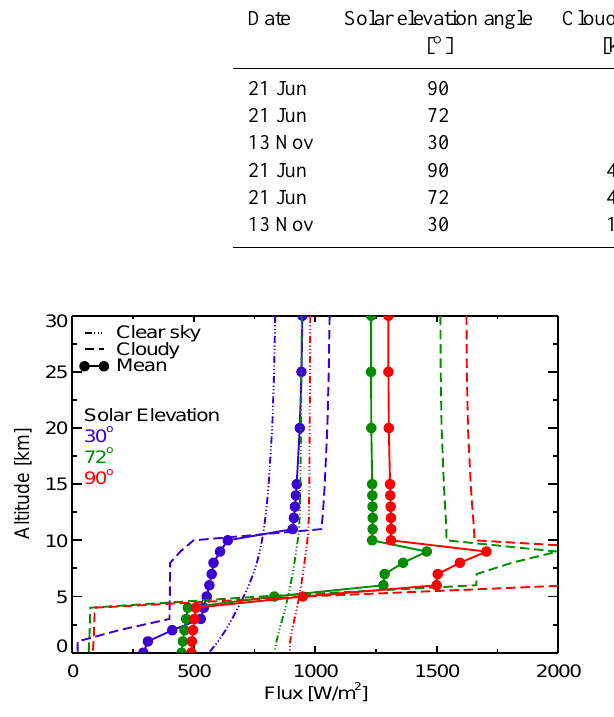
Figure 5. Vertical profiles of the total actinic flux on the sensor Fig. 5. Vertical profiles of the total actinic flux on the sensor for solar elevation angles of 30, 72 and 90 ◦ . The for solar elevation angles of 30, 72, and 90 ◦ . The actinic flux is the actinic flux is the sum of the direct sunlight and diffuse background. The mean actinic flux is the average of sum of the direct sunlight and diffuse background. The mean actinic the cloud-free (dashed-dotted line) and cloudy (dashed line) scenario. The kinks below 10 km result from the flux is the average of the cloud-free (dashed-dotted line) and cloudy cloud layers around 5 and 8 km used in the simulations. (dashed line) scenario. The kinks below 10km result from the cloud layers around 5 and 8km used in the